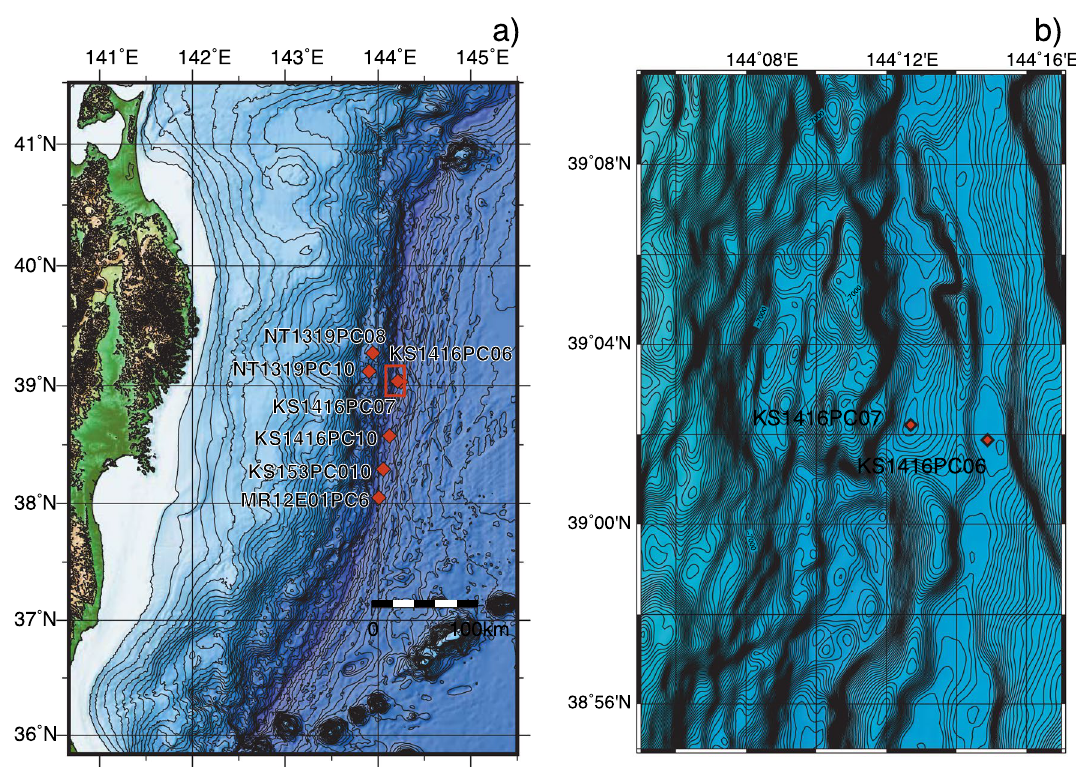
Fig. 1 a Legend map of the study area: Red‑filled diamonds show the location of piston cores in this study and the core locations from earlier studies (Kanamatsu et al. 2017, 2022; Usami et al. 2018); the red box shows the area of ( b ). b Detailed bathymetric map and piston core locations